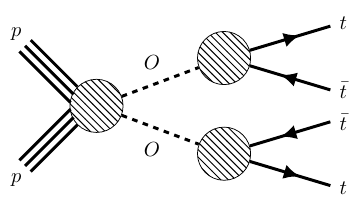
Figure 5 . Schematic diagram for the contribution of the scalar sgluon to the four-top cross section σ ( pp → t ¯ tt ¯ t ) at the LHC. Diagrams for effective vertices are displayed in figures 1 and 2. efficient in SR-10ij50-1ib-MJ500 and 6% efficient in SR-8ij-0ib-MJ500 under this reim- plementation, with scalar and pseudoscalar samples again showing negligible discrepancies. The full results are displayed in figure